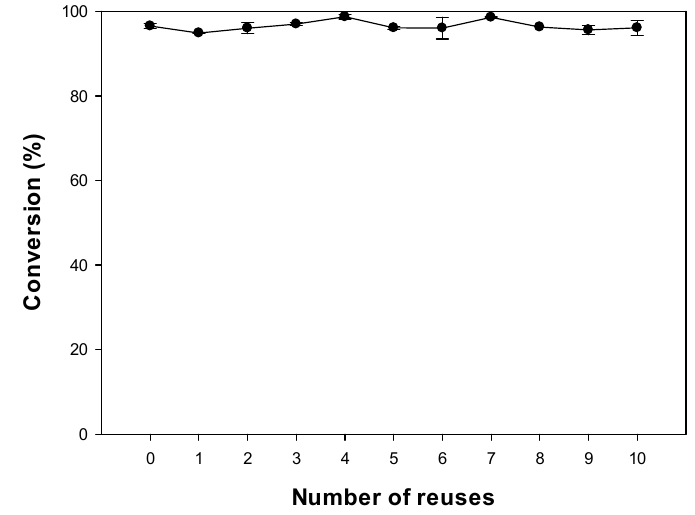
Figure 7. Reusability of selected lipase for high conversion of octyl formate.